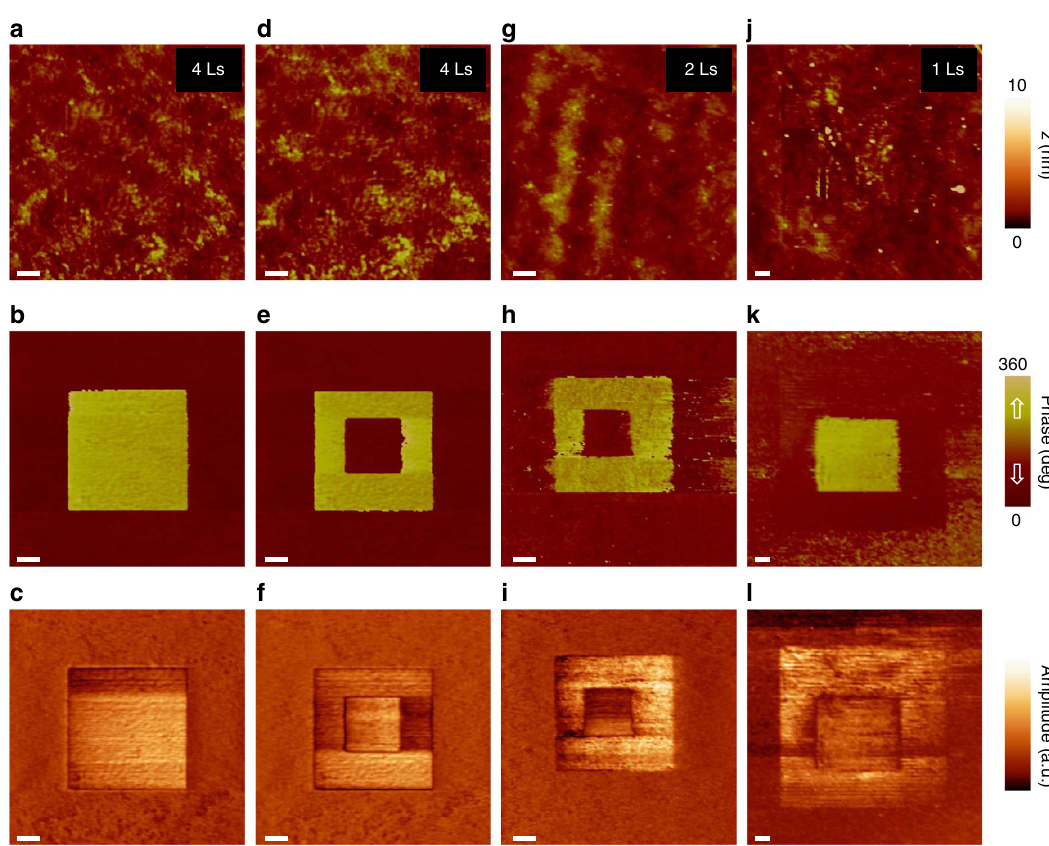
Figure 1 | Ferroelectricity in ultrathin thin films of PVDF. ( a–c ) Topography, PFM phase and amplitude images, respectively, after switching the polarisation upward in the central 5 (cid:2) 5 m m 2 area of a 4Ls-thick PVDF film. ( d–f ) Topography, PFM phase and amplitude images, respectively, of the same area after switching back the polarisation downward in the central 2.5 (cid:2) 2.5 m m 2 area. ( g–i ) Topography, PFM phase and amplitude images, respectively, after sequentially switching the polarisation upward in the central 5 (cid:2) 5 m m 2 area and switching the polarisation downward in the central 2 (cid:2) 2 m m 2 area of a 2Ls-thick PVDF film. ( j–l ) Topography, PFM phase and amplitude images, respectively, after sequentially switching the polarisation downward in the central 10 (cid:2) 10 m m 2 area and switching the polarisation upward in the central 5 (cid:2) 5 m m 2 area of a 1Ls-thick PVDF film. Scale bar, 1 m m.